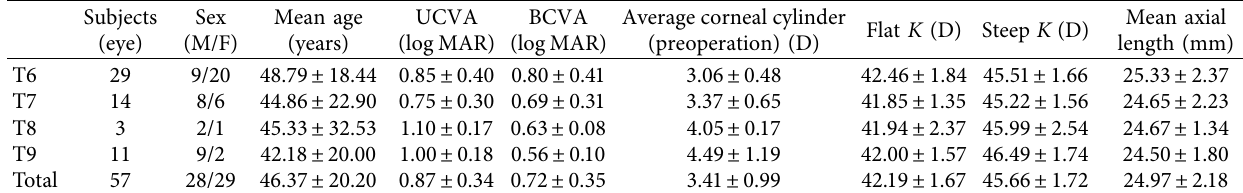
Table 1: Preoperative patient demographic data.